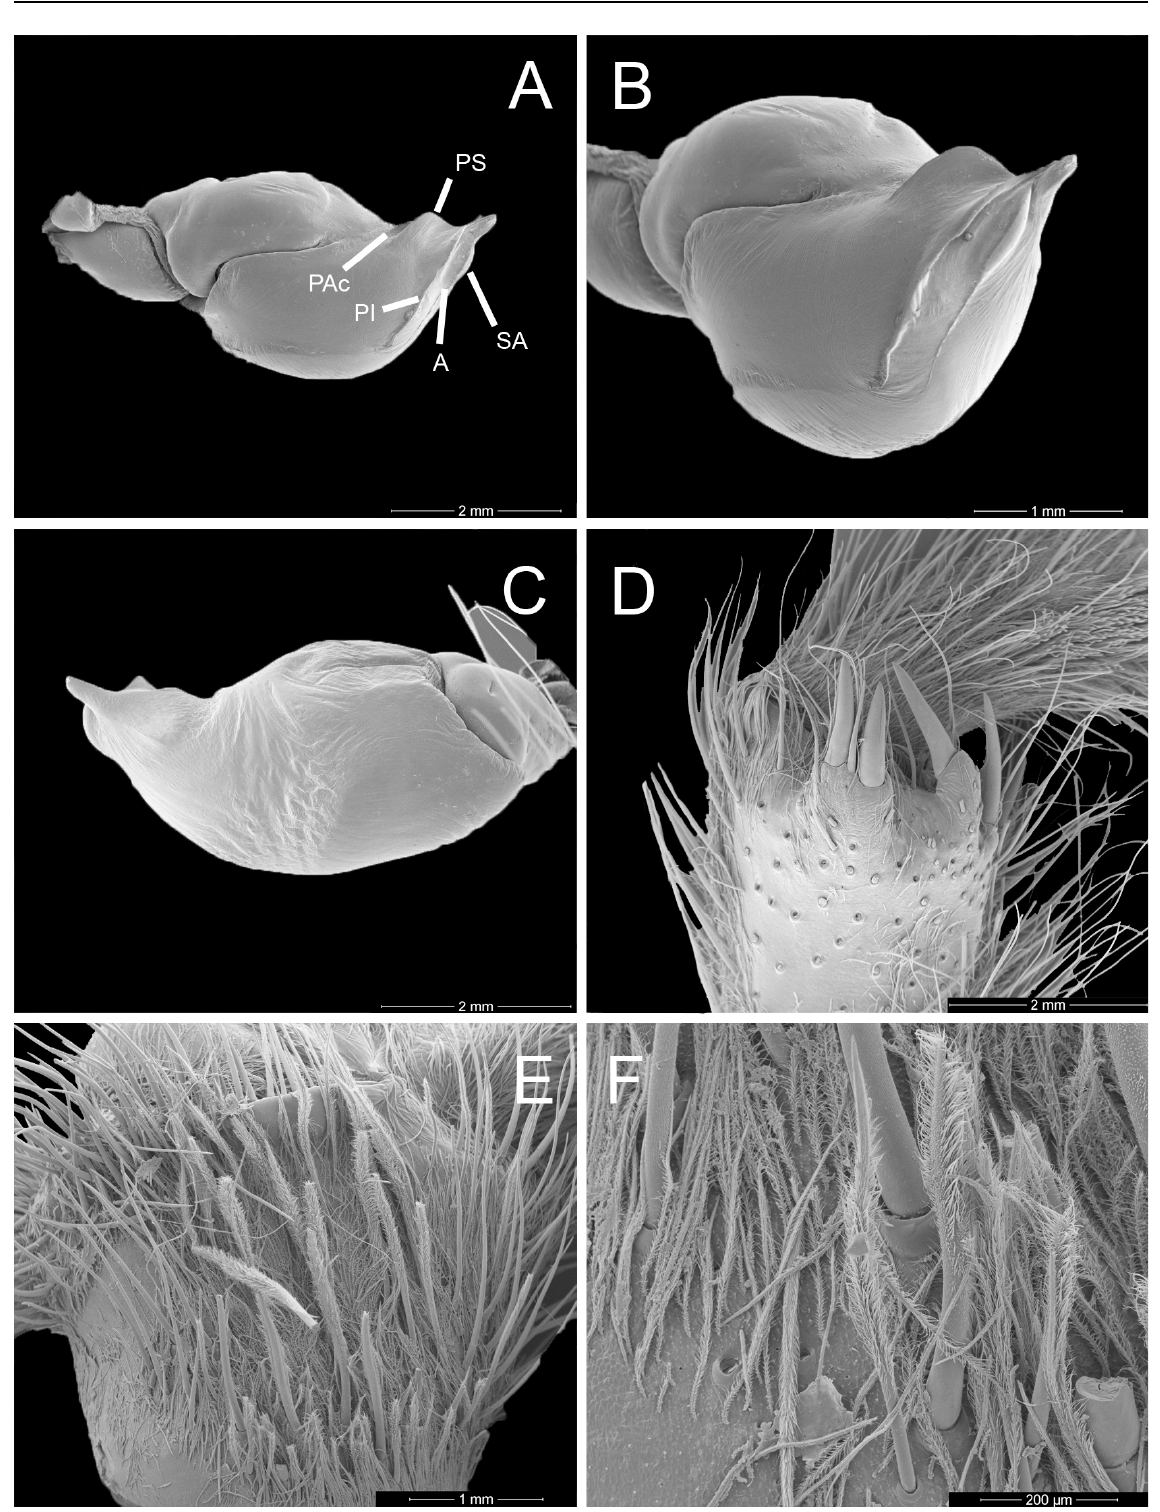
Fig. 22. Umbyquyra belterra gen. et sp. nov., holotype, ♂, Flona do Tapajós, Belterra, Pará, Brazil (IBSP 167421). A . Palp, prolateral. B . Anterolateral. C . Retrolateral. D . Tibial apophysis, retrolateral. E . Stridulatory organ, trochanter. F . Trochanter I. Abbreviations: see Material and